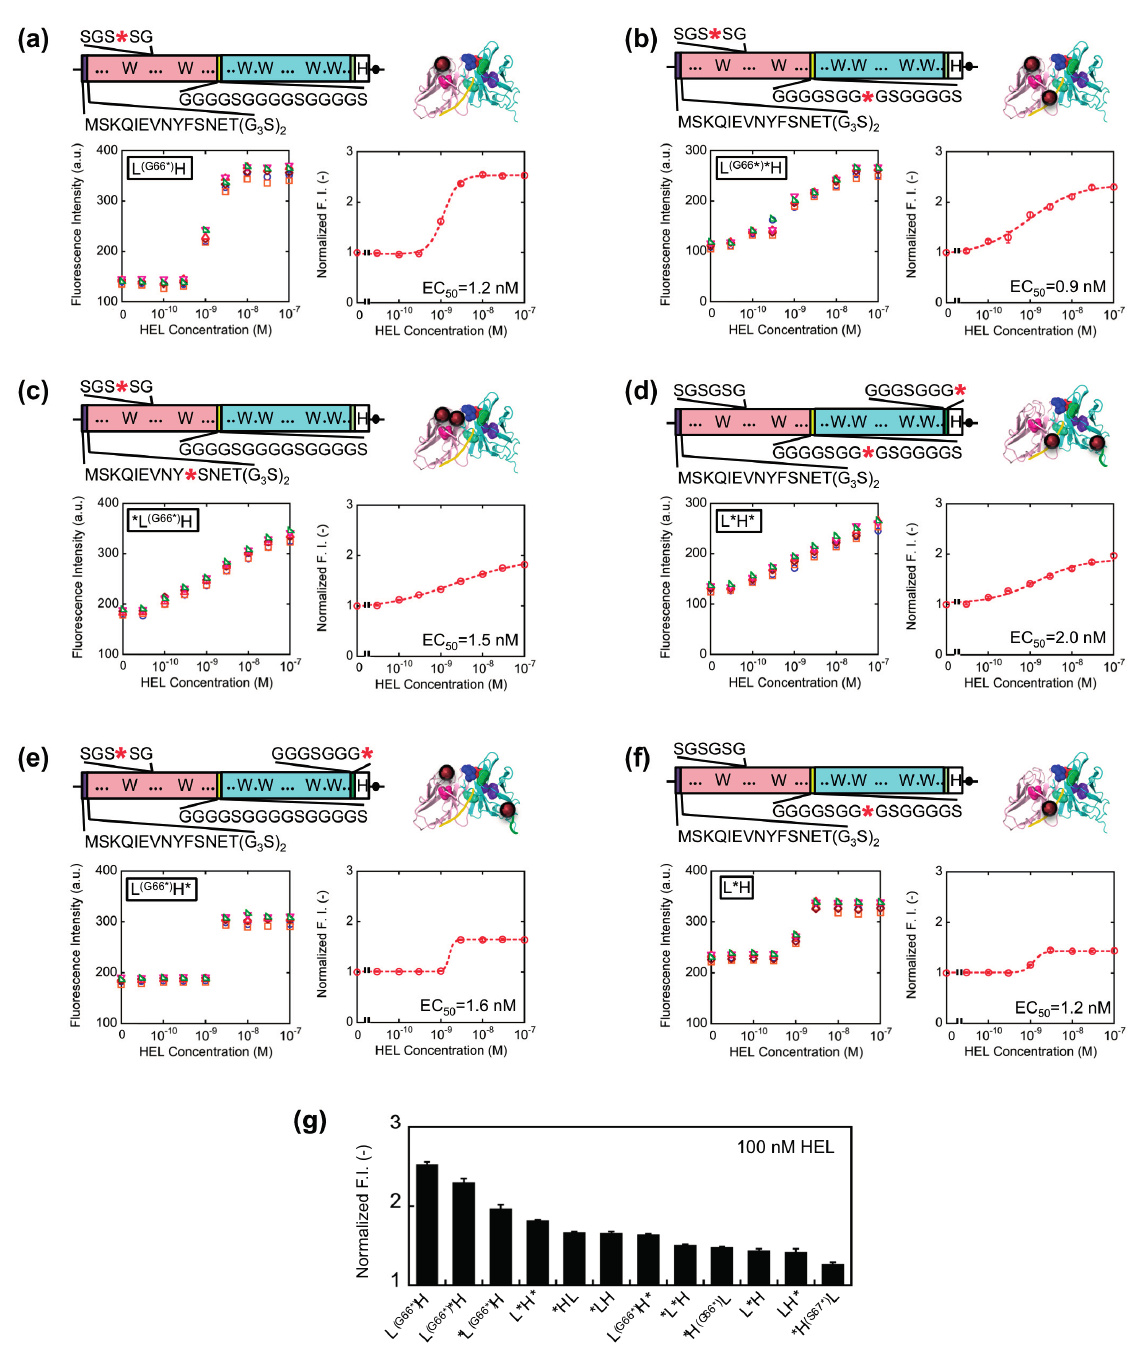
Figure 4. ( a – f ) Schematic presentations of each Q-body gene (upper left) and of possible location of the dye(s) on the Q-body in the absence of antigen, and corresponding titration curves (lower). Error bars represent ±1 SD (n = 6); ( g ) Comparison of the